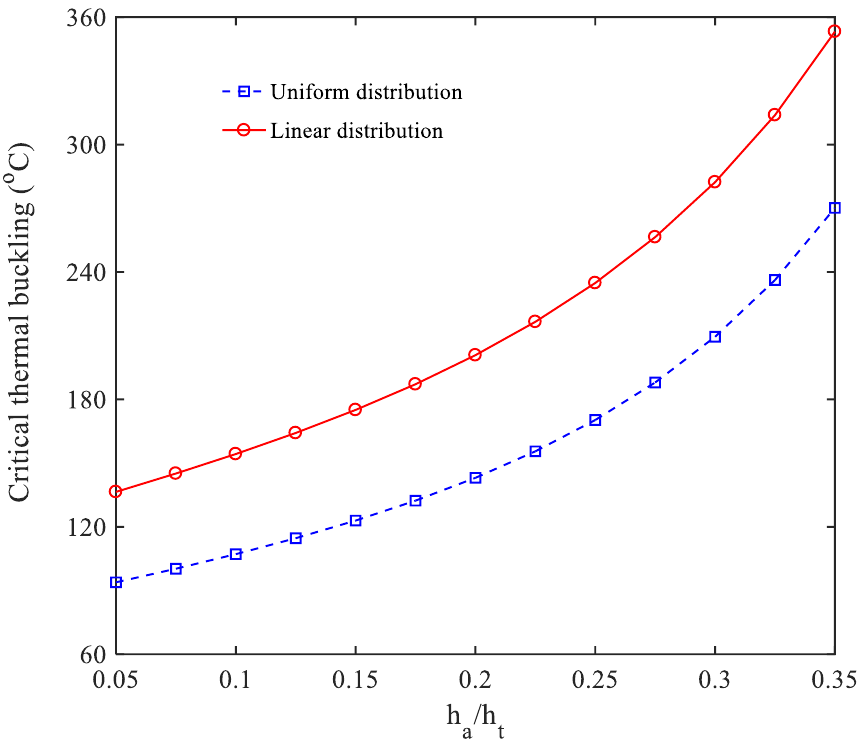
Figure 9. Variation of the critical thermal buckling vs. h a / h for a linear and uniform thermal distribution ( n = 1, h / L = 0.04, V SMA = 0.2 and ε 0 = 2% ).